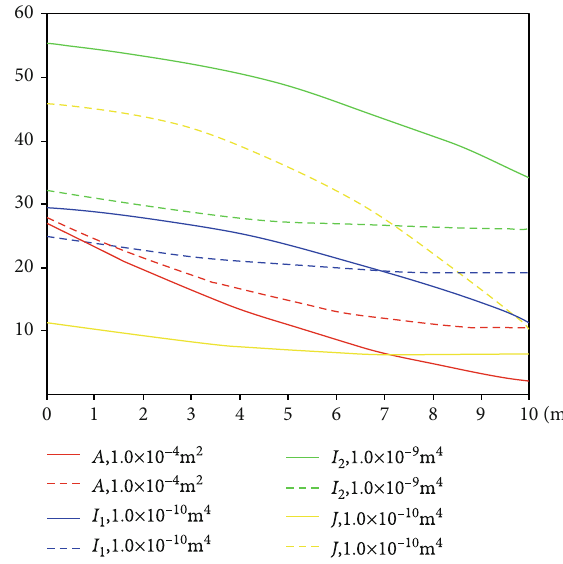
Figure 9: The section properties of the spar fl ange along the length of the spar (case